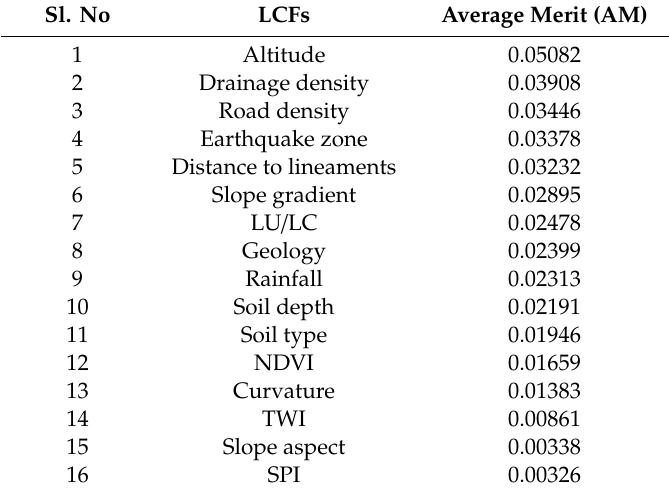
Table 3. Average merit of the LCFs in the